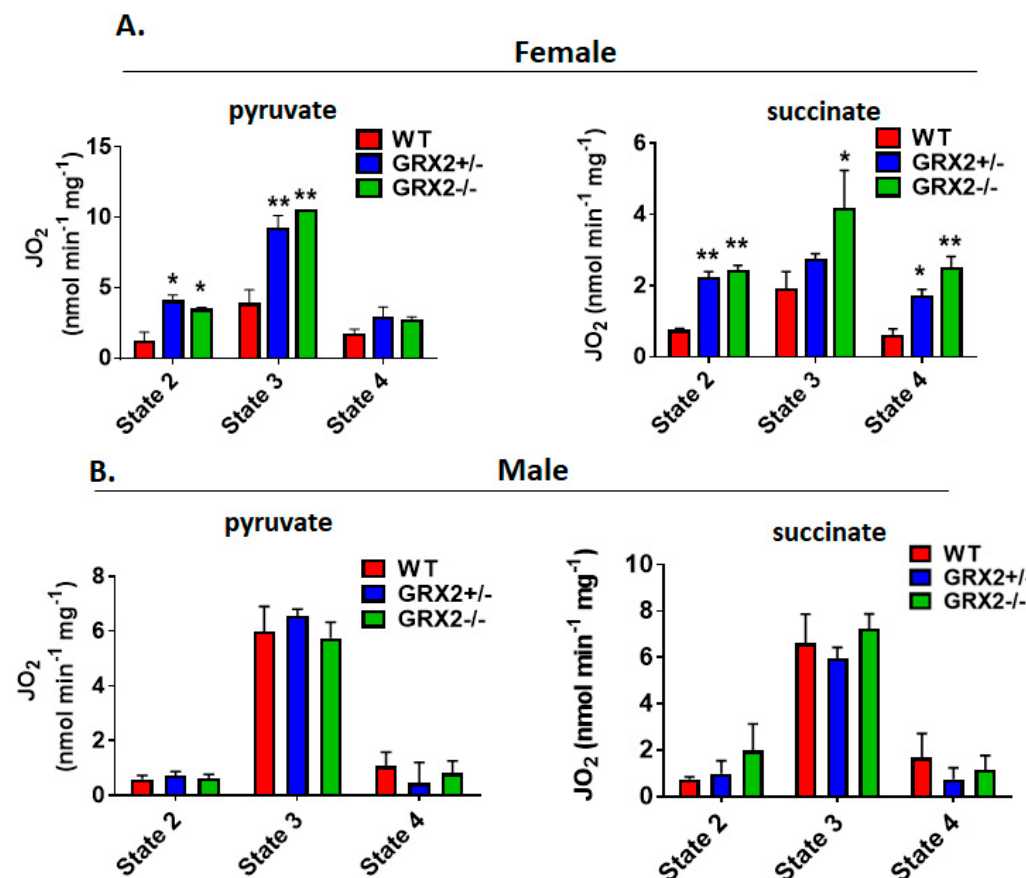
Figure 3. Polarographic measurement of the rate of O 2 consumption by liver mitochondria isolated from female and male GRX2-deficient mice and WT littermates. ( A ). Assessment of the three respiratory states of mitochondria from female mice oxidizing pyruvate (10 mM) and malate (2 mM) or succinate (5 mM). ( B ). Assessment of the three respiratory states of mitochondria from male mice oxidizing pyruvate (10 mM) and malate (2 mM) or succinate (5 mM). n = 4, mean ± SEM, 1-way ANOVA with a post-hoc Tukey’s test. *: p ≤ 0.05, **: p ≤